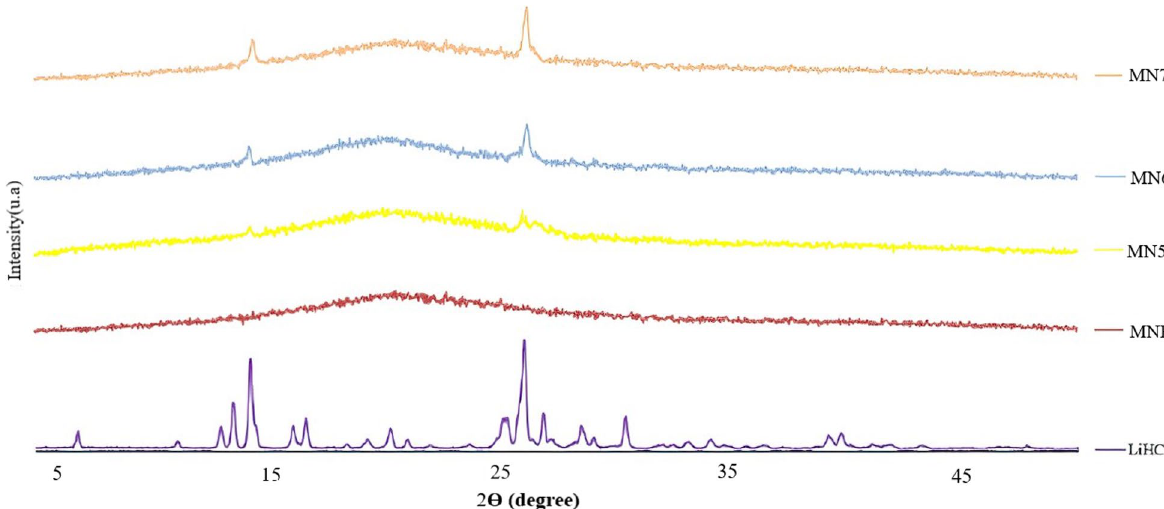
Fig. 7 XRD pattern of LidoHCl, MNB, MN3, MN6, and MN7 samples